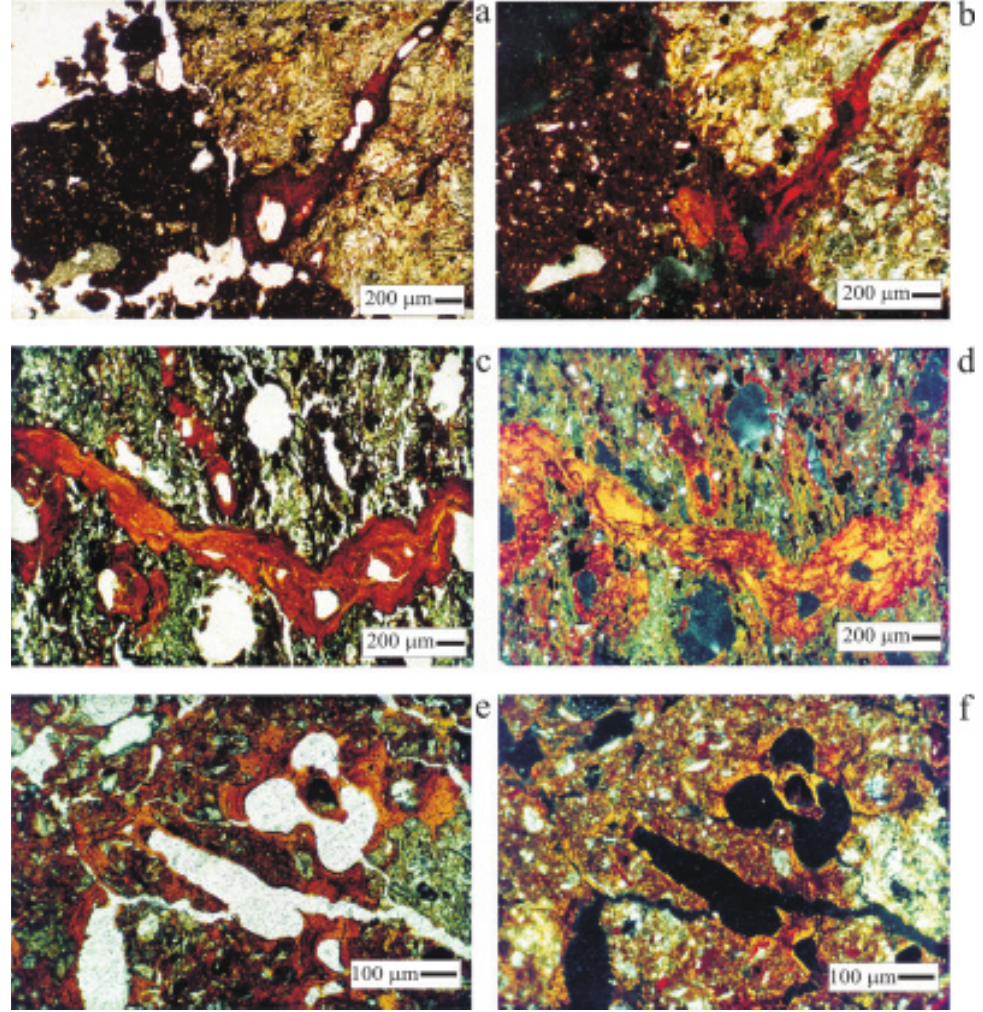
Figura 5. Fotomicrografias selecionadas de seções delgadas dos horizontes Bi dos 3 perfis estudados.